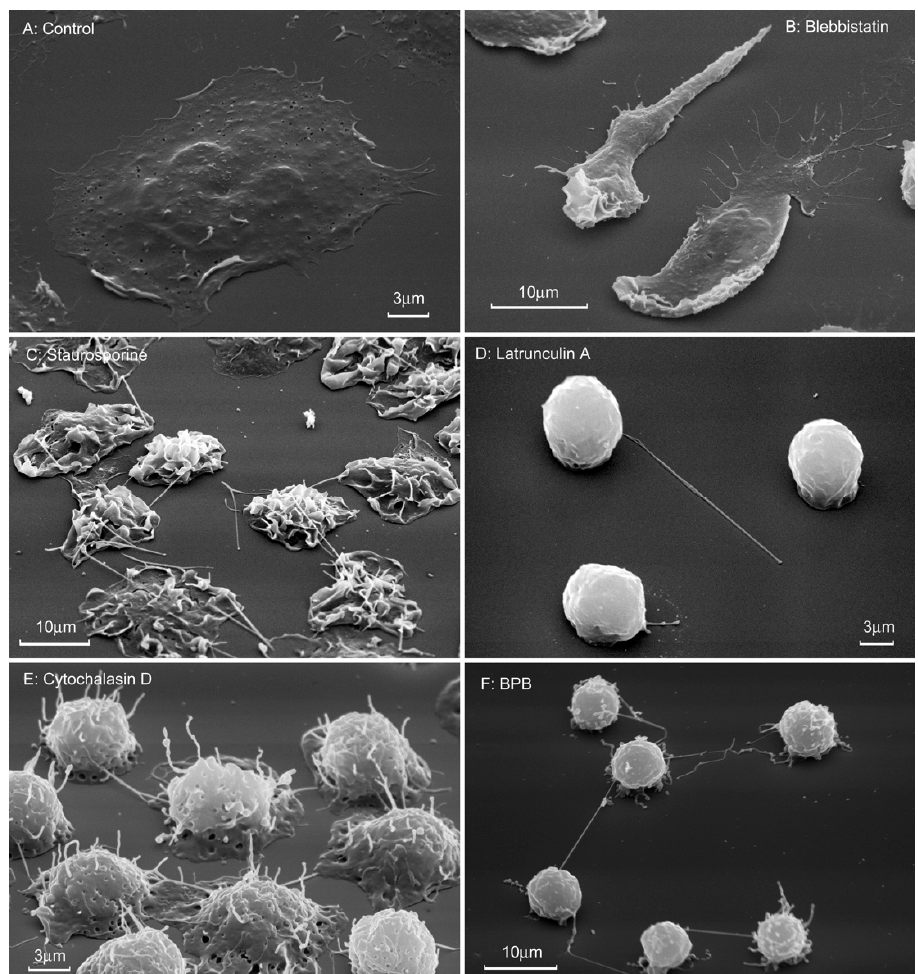
Figure 8. Morphology of neutrophils that were attached to fibronectin in the presence of drugs that violate the integrity of the actin cytoskeleton. Scanning electron microscopy of human neutrophils attached to fibronectin-coated substrates for 20 min under control conditions ( A ) or in the presence of 10 µM blebbistatin ( B ), 0.2 µM staurosporine ( C ), 1 µM latrunculin A ( D ), 10 µg/mL cytochalasin D ( E ), or 25 µM 4-bromophenacyl bromide ( F ). Pictures represent typical images observed in three independent experiments.